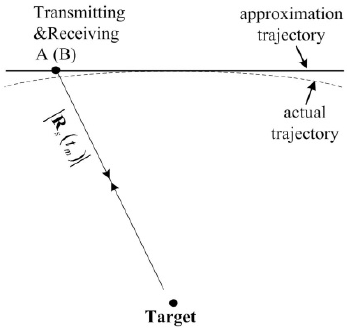
Figure 2. The stop-go model.